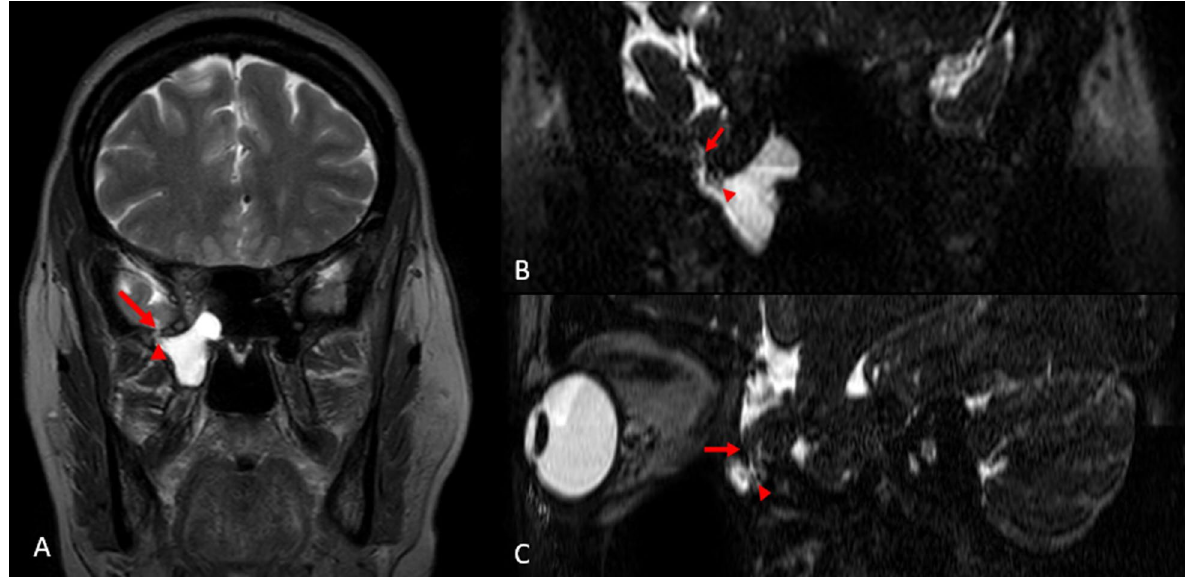
Fig. 6 A T2W image coronal section showing the defect in the right greater wing of sphenoid bone (red arrow) with predominant downward herniation of meninges and adjacent minimal brain parenchyma (red arrowhead). MRI brain CISS sequence B Coronal and C sagittal sections showing the defect in the right greater wing of sphenoid bone (red arrow) with downward herniation of meninges and adjacent minimal brain parenchyma (red